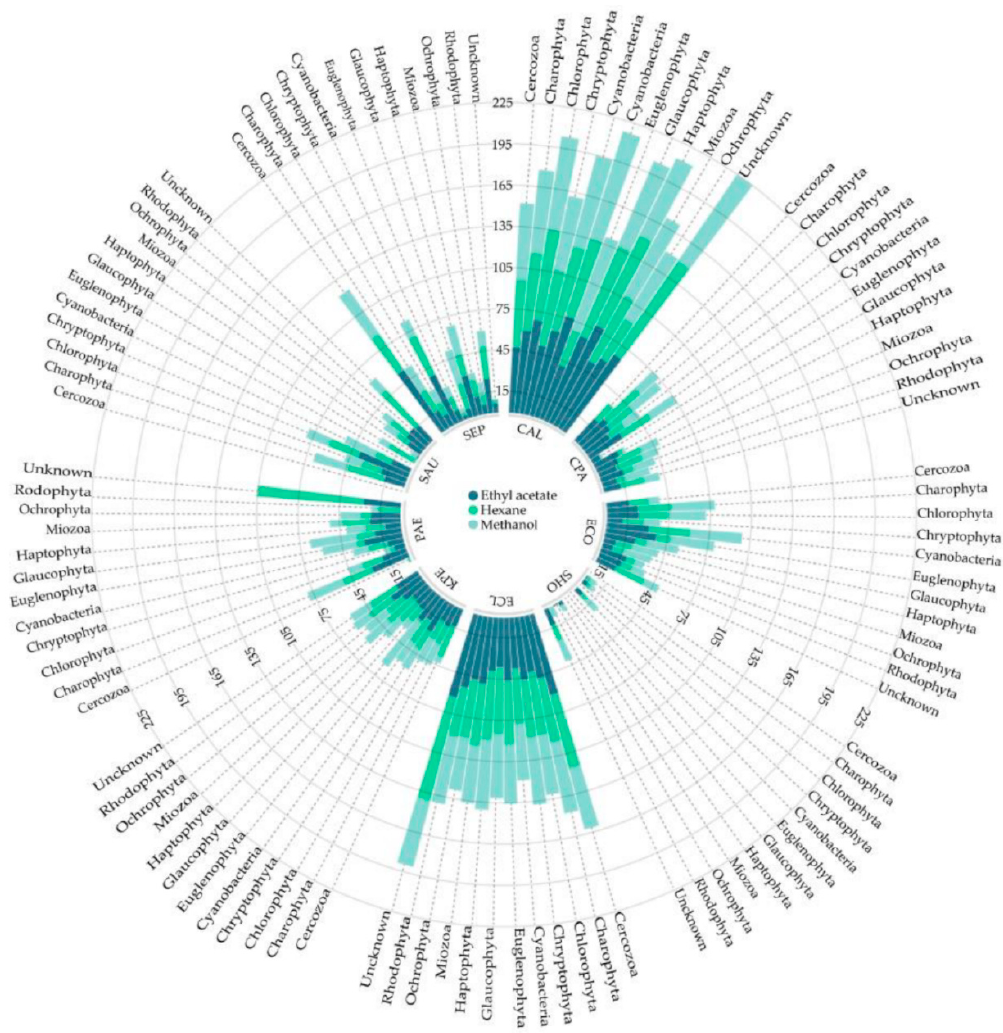
Figure 5. Circular dot plot representing the biofilm inhibition ratio (%) of each bacterium in relation to the solvent employed (ethyl acetate, hexane, and methanol), according to the microalgae and cyanobacteria phylum. CAL: C. albicans; CPA: C. parapsilopsis ; ECO: E. coli ; SHO: S. hominis ; ECL: E. cloacae ; KPE: K. pneumoniae ; PAE: P. aeruginosa ; SAU: S. aureus ; SEP: S. epidermidis . [67].